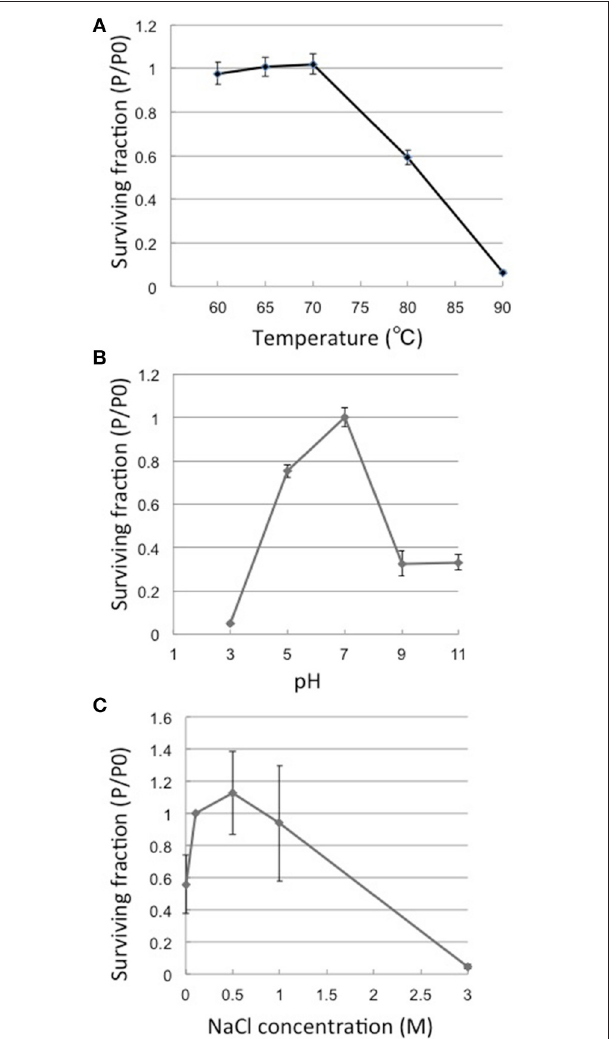
FIGURE 2 | Heat, pH and salt stability of ϕ OH3. Surviving fractions (P/P0) are plotted, where P0 is the ϕ OH3 initial titer, and P is the mean titer from triplicate assays after incubation for 1h at the indicated temperature (A) , 24h at the indicated pH (B), or 24h at the indicated NaCl concentration (C) .